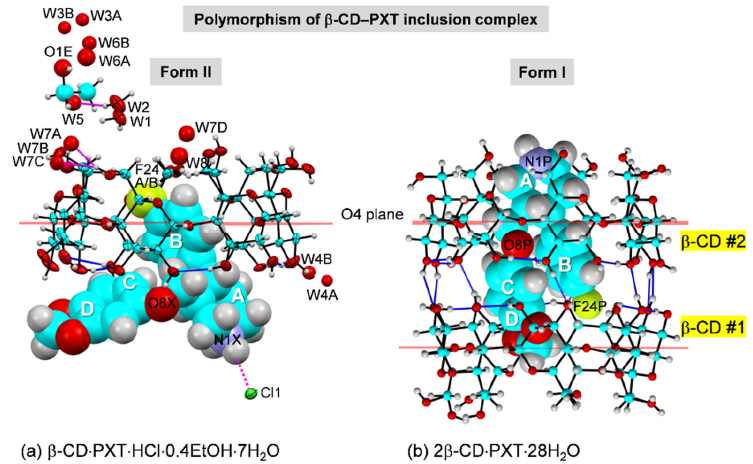
Figure 4. Distinct inclusion scenarios of ( a ) 1:1 β-CD–PXT HCl (form II) and ( b ) 2:1 β-CD–PXT base (form I [35]). ORTEP diagrams are drawn at a 30% probability level. For clarity, the PXT molecules are shown in the space-filling model and water molecules in form I are omitted. Note that PXT exists in freebase (form I [35]), whereas PXT is protonated as PXT–H + and directly linked by Cl − (form II), see magenta dotted line. The O–H···O hydrogen bonds within β-CDs and between various molecules are shown with blue and magenta connecting lines, respectively.